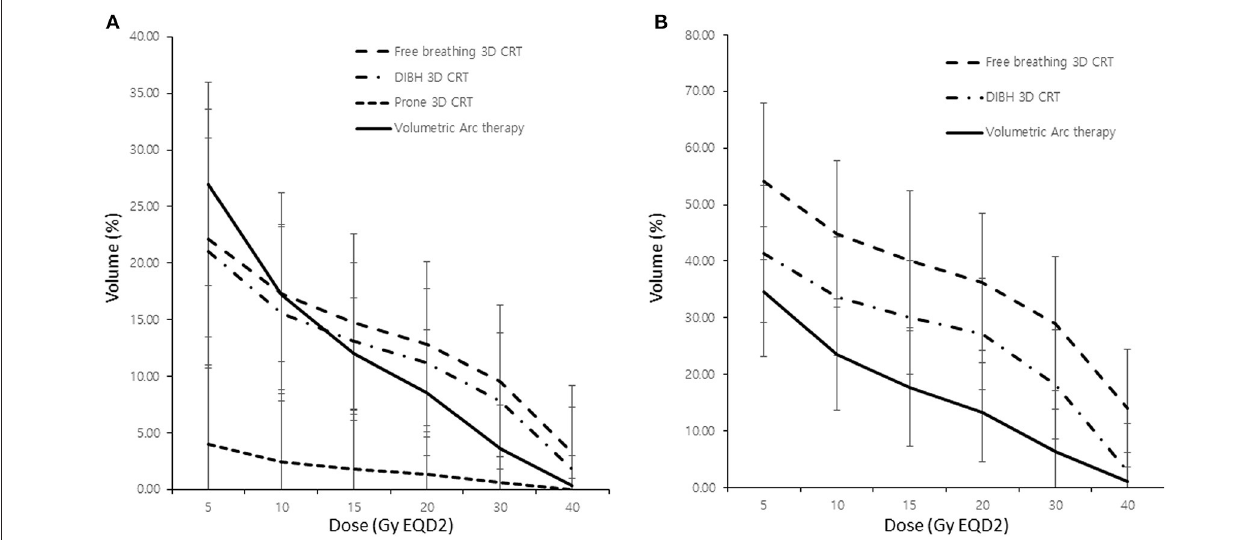
FIGURE 1 | Comparison of lung dose according to the radiotherapy modality without (A) and with (B) internal mammary lymph node irradiation. 3D CRT, three-dimensional conformal radiotherapy; DIBH, deep inspiration breath hold; V χ , percentage of the total volume exceeding χ Gy.